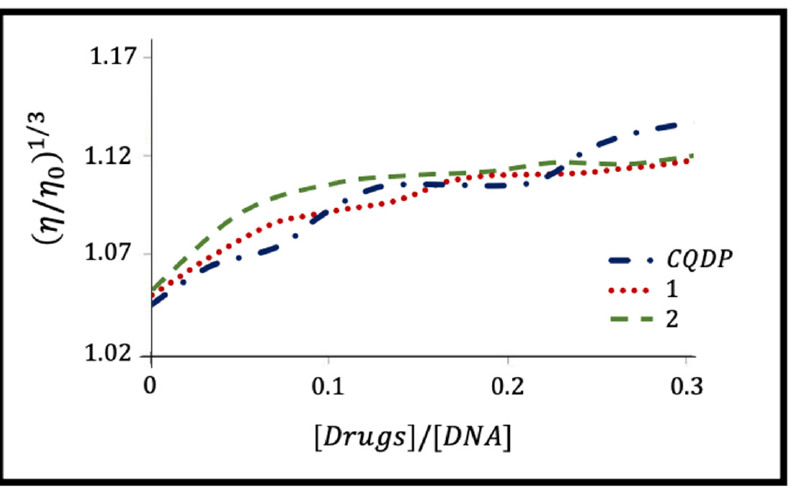
Figure 5. Effect of increasing concentration of [Cu(CQ)(PPh 3 ) 2 ]NO 3 , complex 1 (red dotted line), [Cu(CQ) 2 ]Cl, complex 2 (green dash line) and CQDP (blue long dash line) on the relative viscosity of CT DNA at 25 °C. Molecules interacting with the DNA can affect its melting temperature (Tm), at which 50% of double stranded DNA changes to single stranded DNA. The thermal denaturation curves of DNA are shown in Figure 6. The free DNA melted at 80.7 ◦ C. CQDP at a molar ratio (Ri) 0.05 (Table 1) had no effect; however, in higher ratios (Ri 0.1 and 0.2) it increased its melting temperature, ∆ Tm = +3.7 ◦ C by stabilizing its double